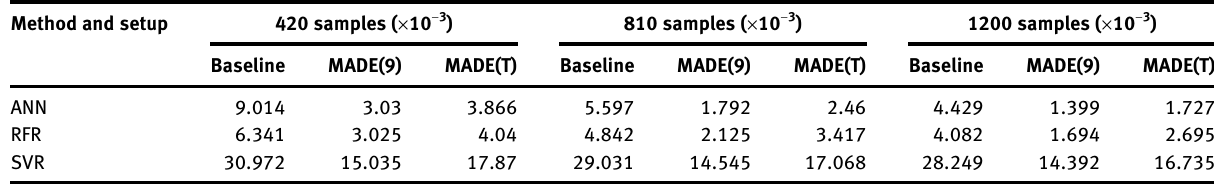
Table  : Mean absolute error (MAE) of three machine learning (ML) models for the fi rst category metamaterials. Method and setup